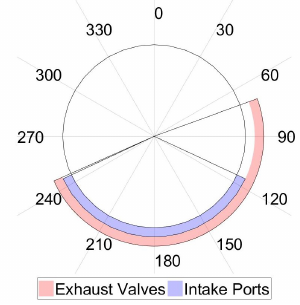
Figure 3. Phase diagram of intake ports and exhaust valves opening and closure as a function of